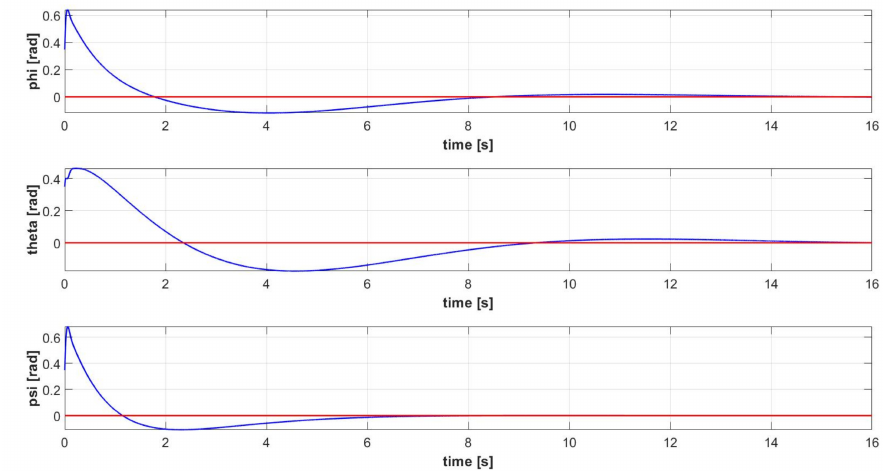
Figure 4. Euler angles signals [ φ ( t ) , ϑ ( t ) , ψ ( t ) ] of the controlled attitude system (blue): PID-based Attitude Stabilizer